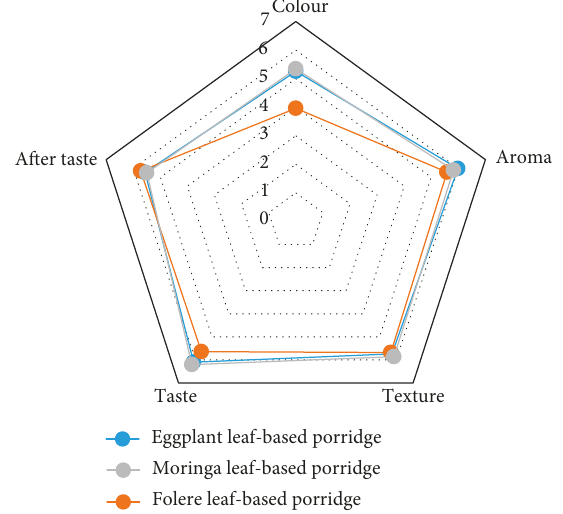
Figure 2: Hedonic appreciation of the three porridges based on five